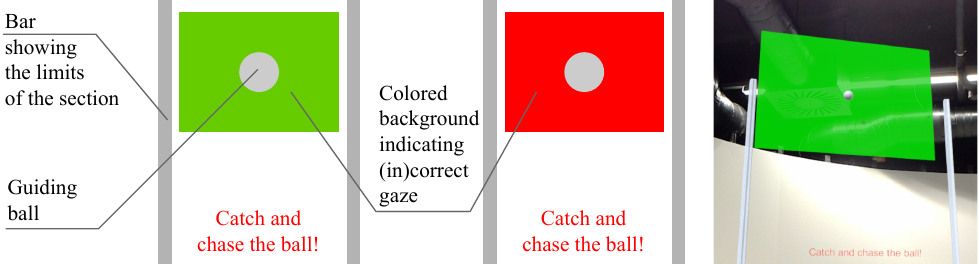
Figure 2. AR Moving ball guidance for the scanning pattern in the